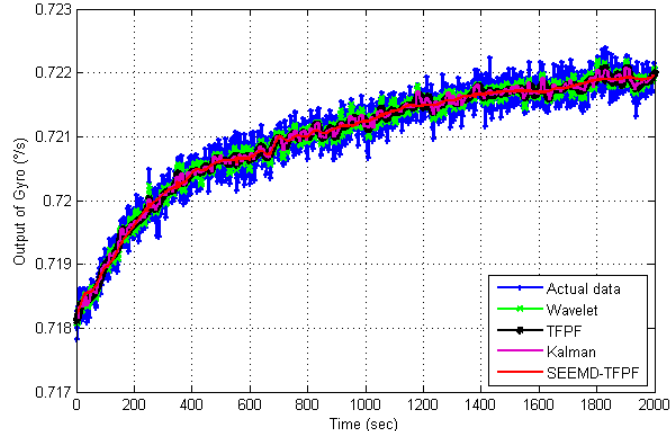
Figure 13. Comparison results of temperature drift signal de-noising by using different methods.